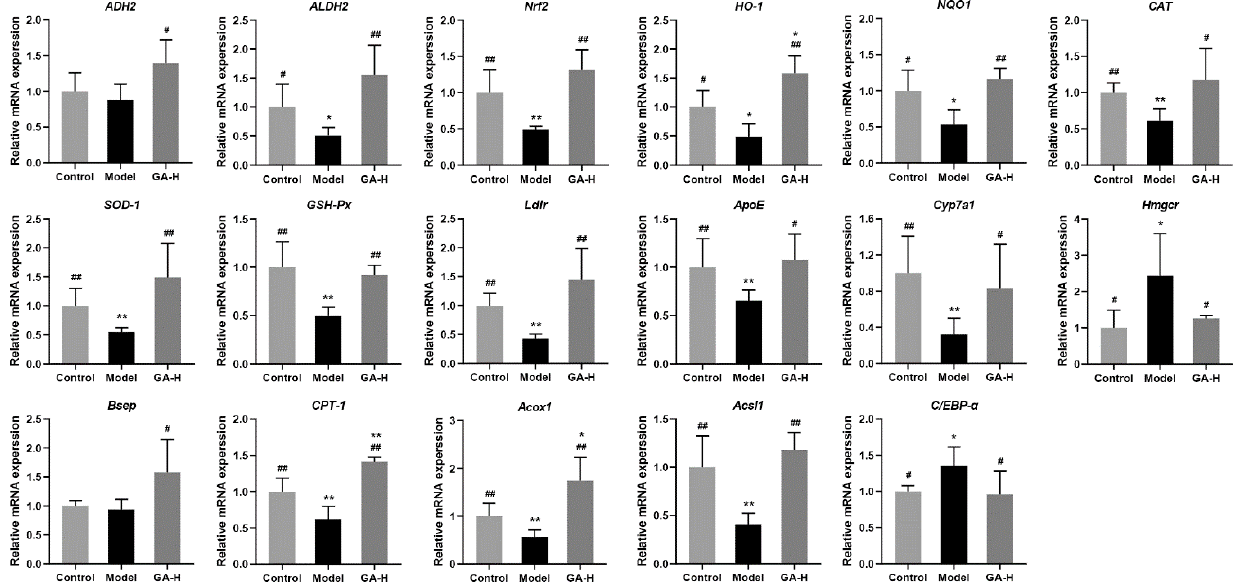
Figure 9. Effects of high-dose GA administration on the mRNA levels of oxidative stress and lipid metabolism correlative genes in livers of mice with excessive alcohol consumption. Values were expressed as mean ± SD, and ## p < 0.01 and # p < 0.05, versus the model group; ** p < 0.01 and * p < 0.05, versus the control group.